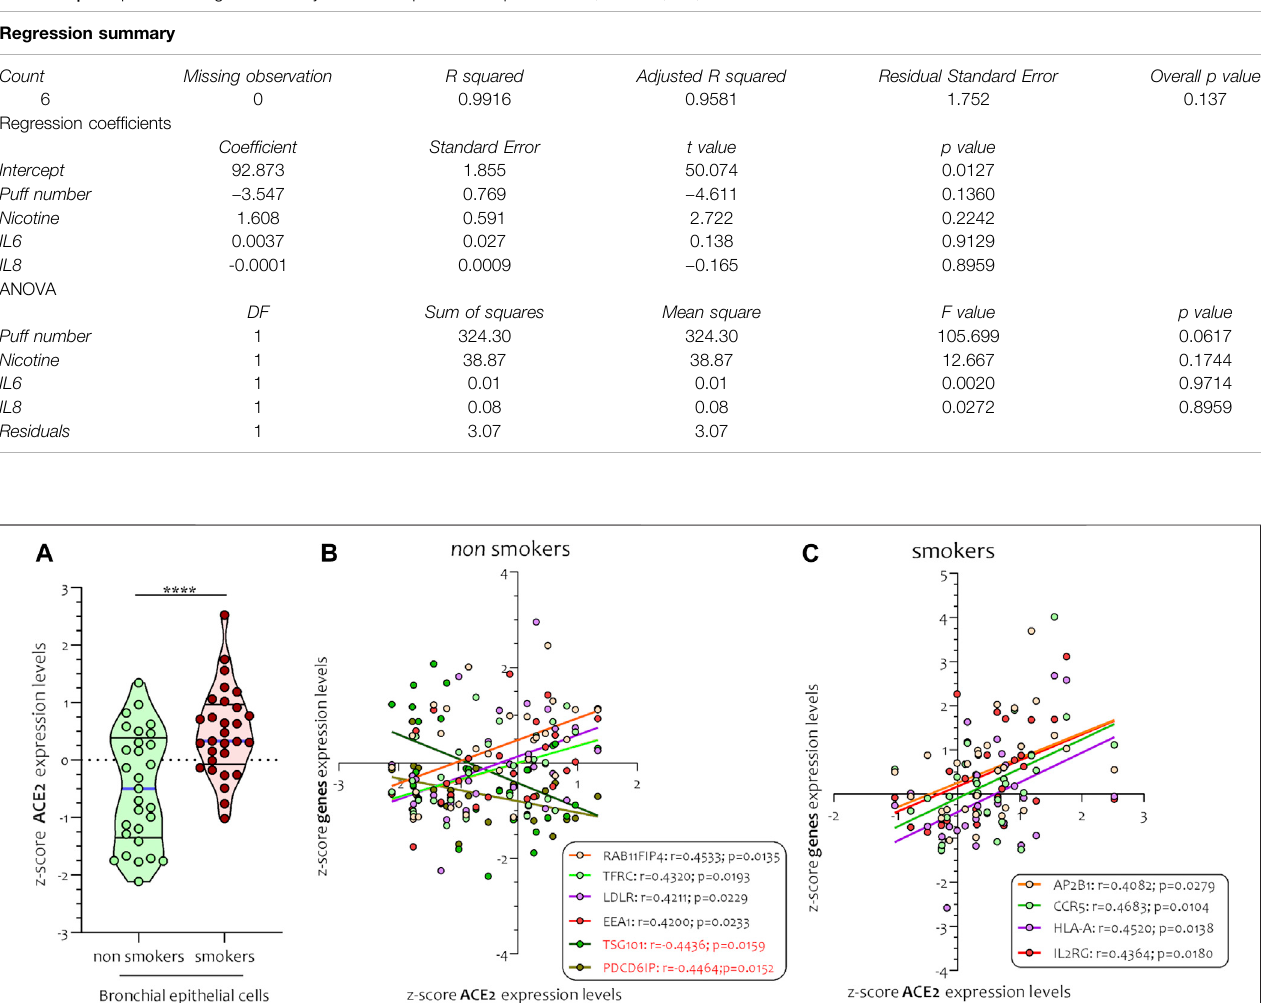
Frontiers in Pharmacology |